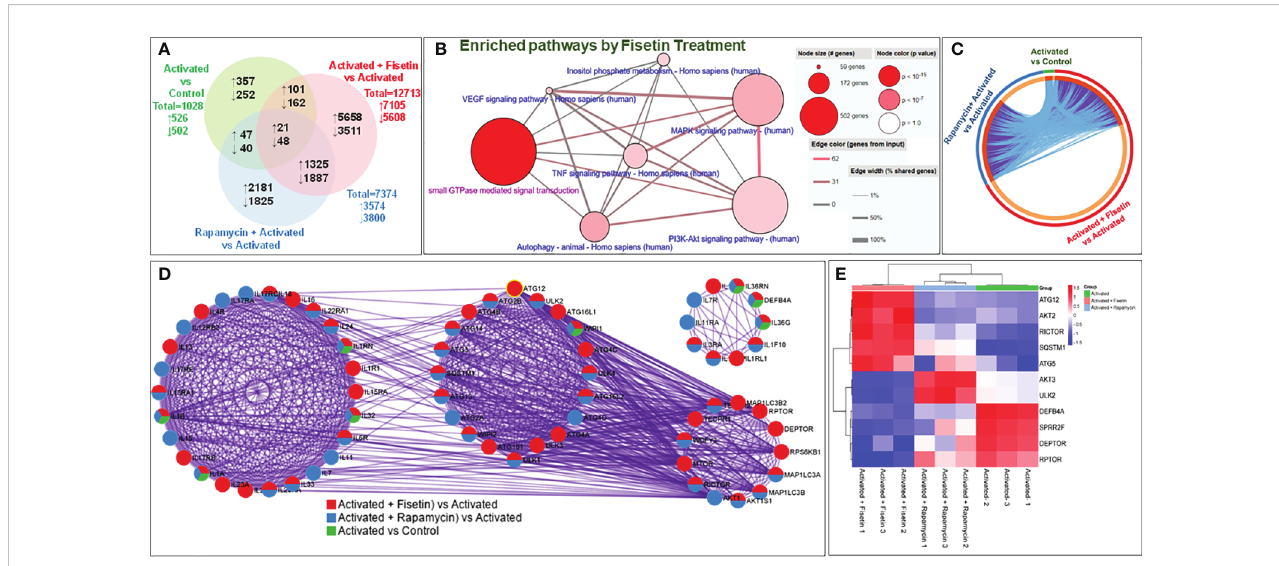
FIGURE 1 Fisetin treatment modulates several targets and signaling pathways in IL-17A/TNF a -stimulated primary keratinocytes. (A) Venn diagram showing the genes that were differentially regulated with >2-fold increase (shown as upward arrow) or decrease (downward arrow) from each comparison across the different groups of treatment and activation with cytokines in keratinocytes. (B) Metascape analysis at systems level of transcriptome pro fi les of 3 groups in circus plot: Activated vs Control (green), Activated + Fisetin vs Activated (red) and Activated + Rapamycin vs Activated (blue) in vitro . The plot shows how 1.5-fold changes differentially expressed genes are overlapped: Each arc represents as individual gene. Dark orange color represents the genes shared by multiple groups which forms purple link. On the contrary, the light orange arc represents unique gene to that list from the group. Light blue color represents different genes but shared ontology terms. There is a trend to see more common functional overlap that means subset of genes of the same biological process. (C) Differential enrichment analysis illustrates the transcriptomic enrichment analysis of genes involved in different important ontology terms (GO/KEGG) in cytokine-activated keratinocytes compared with control represented by circles. Enrichment study of GO/KEGG and hall mark gene sets. The overlap between the input gene lists increases with the thickness of pink linkages. The detailed enrichment study is shown in